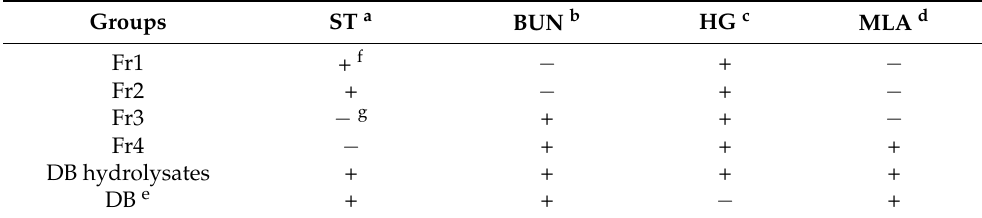
Table 1. Summary of the anti-fatigue effects of DB and its peptides. Groups ST